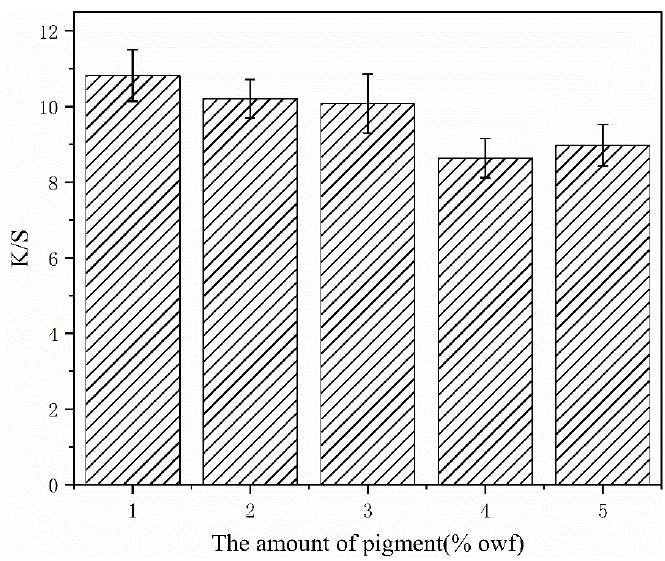
Figure 7. E ff ect of pigment amount on K / S value. Figure 7. Effect of pigment amount on K/S value. Figure 7. Effect of pigment amount on K/S value.